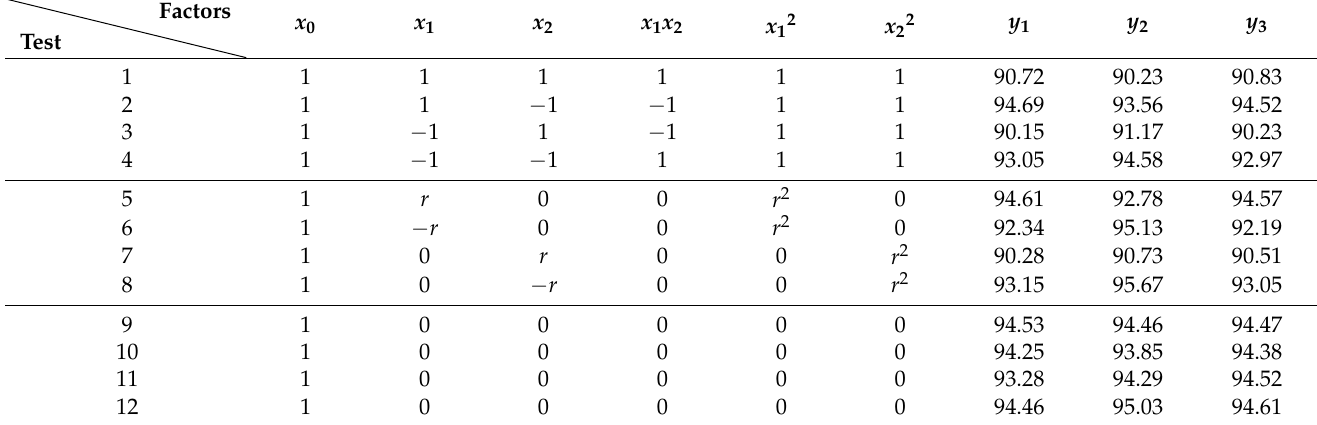
Table 3. Orthogonal quadratic regression test program and results.